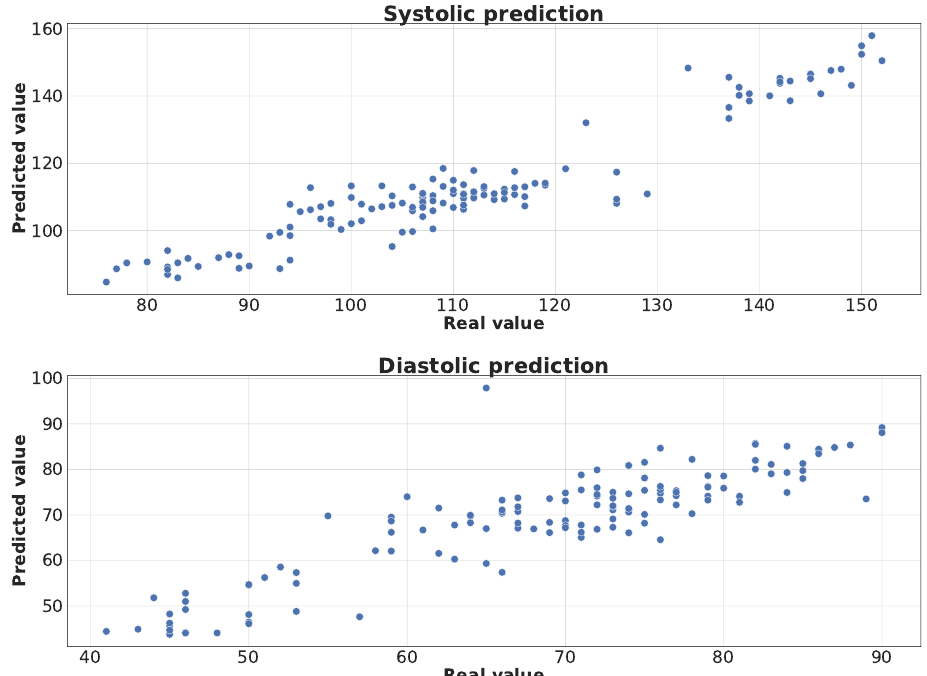
Figure 14. Comparison between real and predicted values for systolic and diastolic predictions using Random Forest over the general